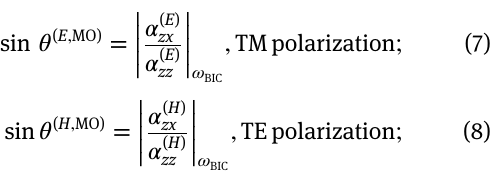
Figure 2: Contour maps of the reflectance spectra R ( 𝜔 ) from an infinite square array of lossless semiconductor ( n = 3 . 5) nanospheres (lattice period a = 300 nm, sphere diameter D = 150 nm), at angles of incidence 𝜃 = 0 ◦ , 5 ◦ , as a function of MO activity 𝛽 (see text) and wavelength 𝜆 , theoretically calculated through CEMD for (a and c) TM and (b and d) TE polarizations: (a and b) normal incidence 𝜃 = 0 ◦ ; (c and d) non-normal angle of incidence 𝜃 = 5 ◦ .